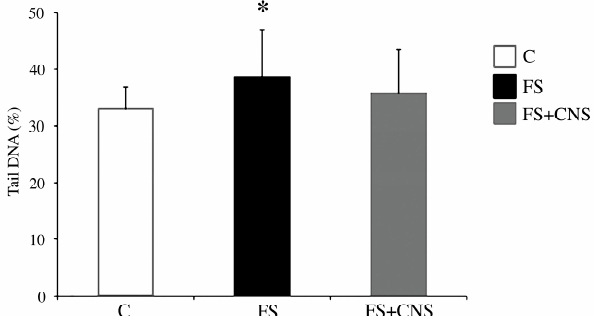
Figure 3. DNA primary damage (% tail DNA) in zebra mussel hemocytes after 48 h exposure to